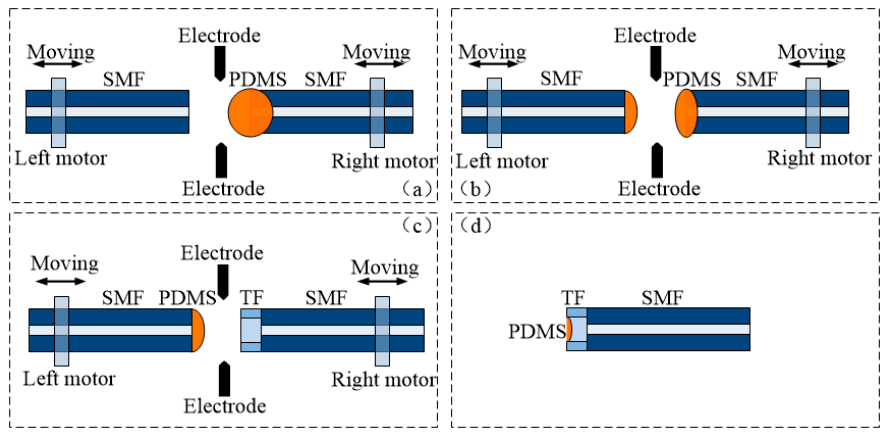
Figure 5. Fabrication process of the PDMS immersed fiber sensor ( a ) First transfer step; ( b )